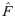
Dependence on g of the stable equilibrium behind the wave front, where s = ξ × g is assumed to covary with g.Fixed parameter values are a = 1, b = 1, w = 0.5, p = 0.7, q = 0.2, and ξ = 1/15. Grey dots give the numerically-simulated normalized values of F^ for each value of w. Similarly, black dots connected by broken and solid lines give the values of C^ and H^, respectively. The brown dots give the numerically obtained speeds. Note the relevant equilibrium behind the wave front is E5 when g < 1 − q = 0.8 and E3 when the inequality is reversed. The heuristically predicted speed is always v=2a(1−w), because 1 + s − p < a(1 − w) for the range of values of s (Appendix 3). For E5, F^ is monotone increasing in g because ξ<w(p−w)/(1−wq) = 1/9, C^ is monotone increasing in g, and H^ is monotone decreasing in g.